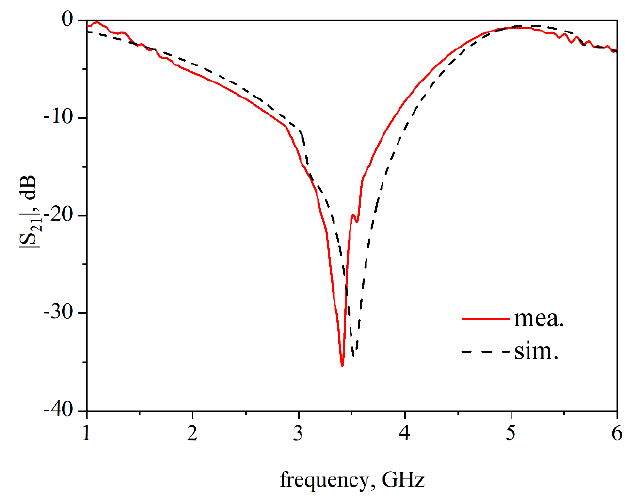
Figure 6. Measured (red line) and simulated (black dashed line) transmission coefficient of FUT.